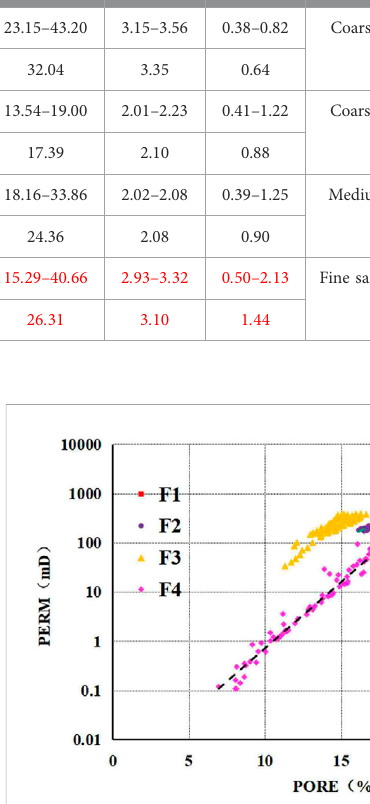
FIGURE 9 Relationship between porosity and permeability of different petrophysical